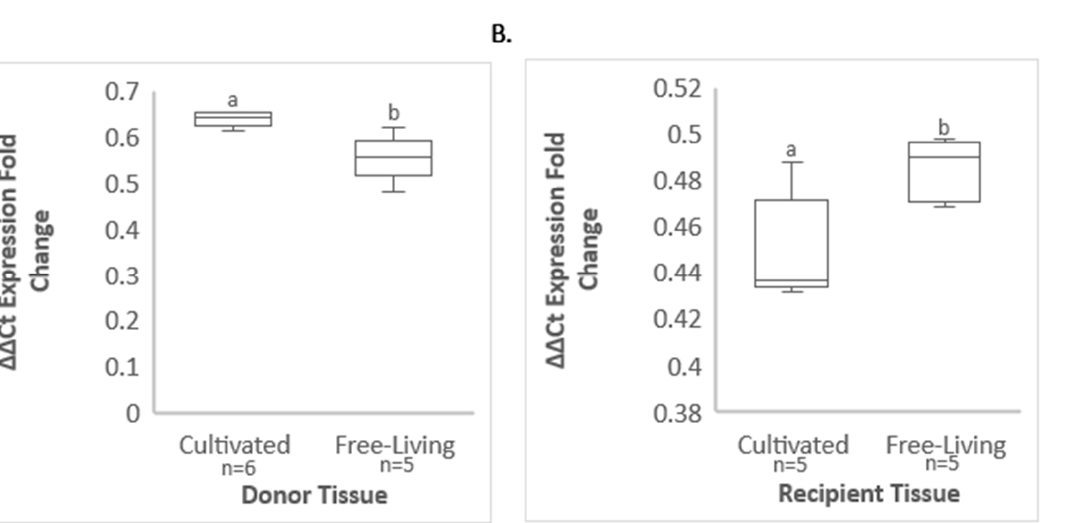
hybrid vines (Free-living) in comparison with donor V. vinifera ‘Cabernet franc’ vines (Cultivated),